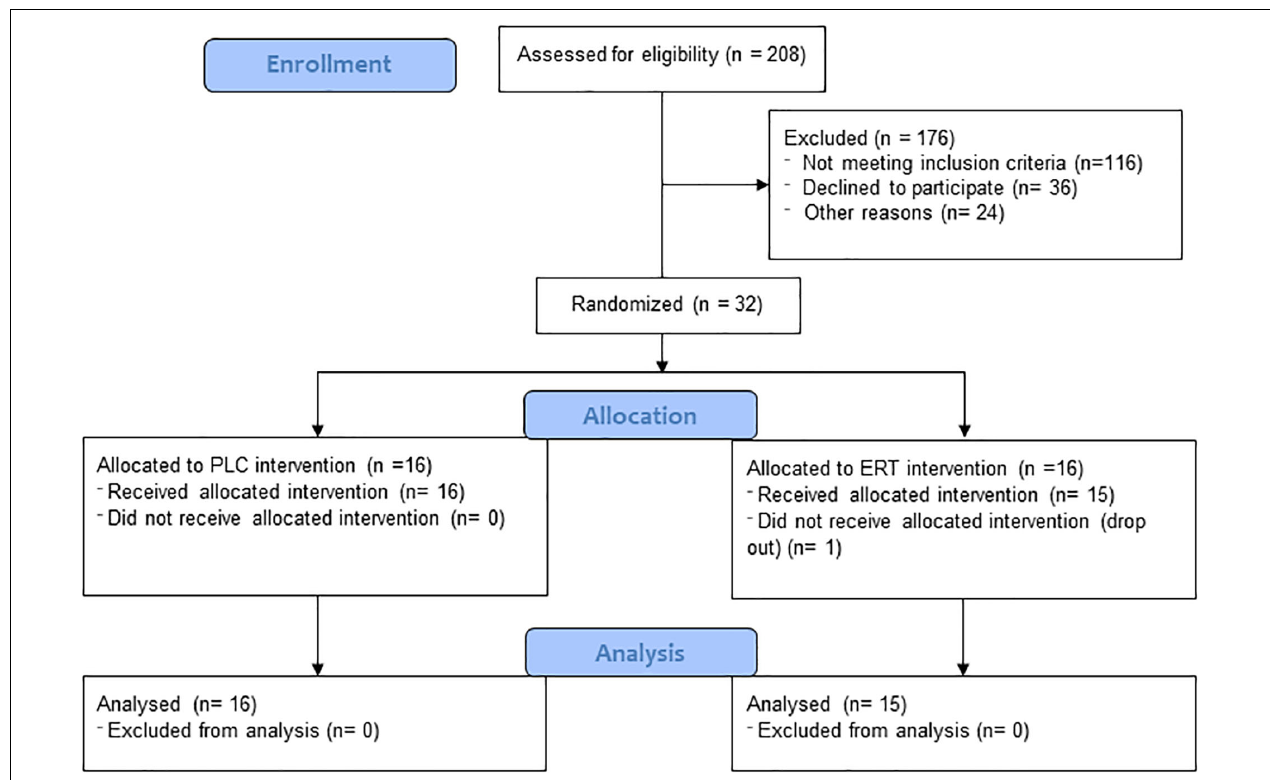
FIGURE 2 | Flow diagram reflecting the recruitment and allocation